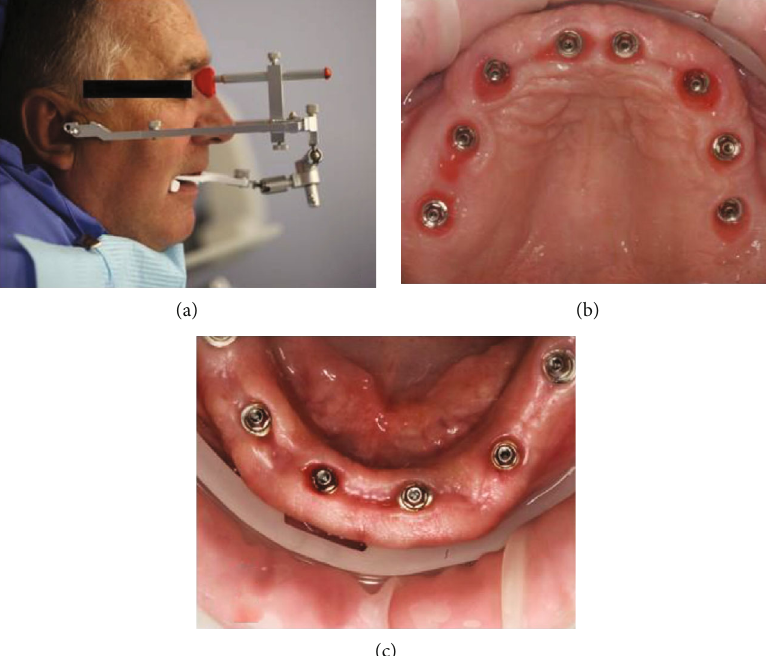
Figure 7: Final prosthetics after 3 month healing (a). Good condition of soft tissues on maxilla (b) and mandible (c) after wearing temporary screw-retained multiunit abutment-supported